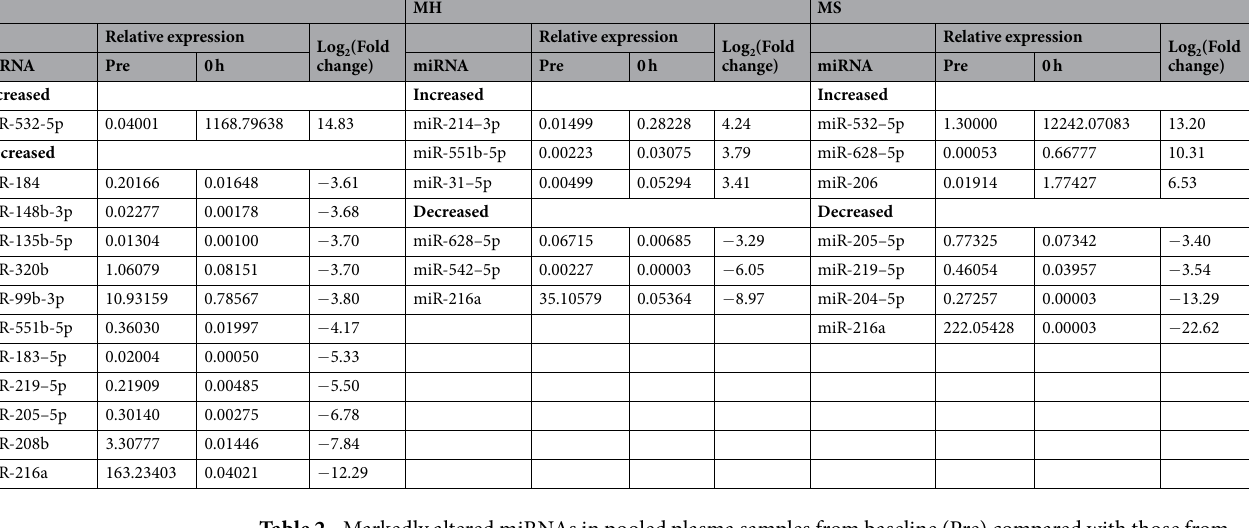
IL-10. Moreover, a significant negative correlation (R = − 0.33, p = 0.03) was observed between alterations in the plasma miR-532 level and the IGF-1 level (Fig. 4B,C,E). Circulating miRNAs in response to the acute muscle hypertrophy protocol and association with conventional biomarkers. Three myomiRs, miR-133a, miR-133b and miR-206 that were not affected by SE, showed different expression patterns in response to MH. The plasma levels of miR-133a were significantly decreased ( p < 0.05) 0 h postexercise, and restored to the baseline level after 1 h recovery ( p > 0.05) (Fig. 5A). The plasma levels of miR-133b level were markedly increased after 24 h recovery ( p < 0.05) (Fig. 5B). The plasma